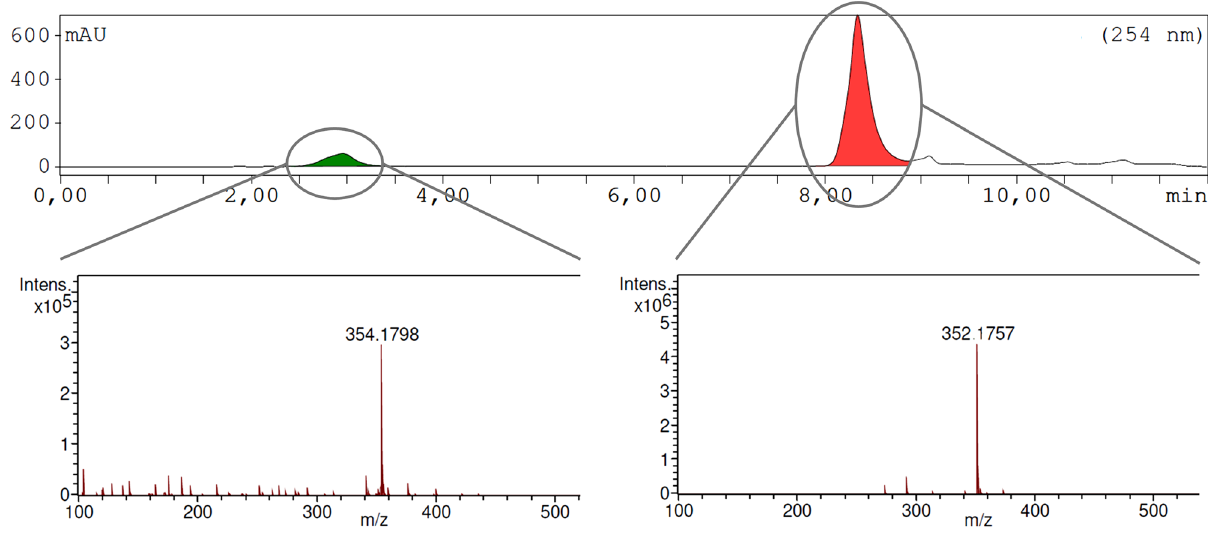
Figure 8. Isomerization of 2 using HCl in [ 18 O]H 2 O. The UV-HPLC chromatogram and HRMS spectra of collected fractions after 60 min at 75 °C are shown: [ 18 O] 4 (t R = 2.9 min, expected mass: 354.1816 m/z), 2 (t R = 8.3 min, expected mass: 352.1768